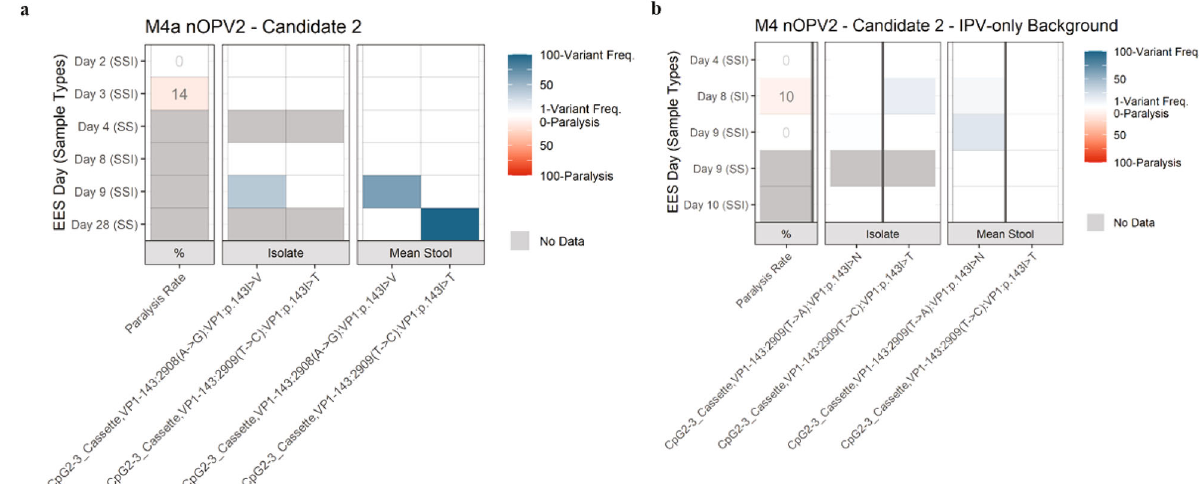
Fig. 6 nOPV2-c2. Frequency of variants in EES at known attenuation sites and mTgmNVT results. Participant vaccination history is IPV only. EES day shown with mTgmNVT result (red colour gradient) and variant frequency (blue colour gradient) averaged across two stool replicates (SS) and culture-ampli fi ed virus (I), if present. Amino acid associated with variant indicated, if applicable. S = Stool replicate; I = Culture- ampli fi ed virus isolate (SSI = Two stool replicates and culture-ampli fi ed virus isolate; SI = Single stool replicate and isolate). White cells = variant not detected. Grey cells = mTgmNVT result not available or no NGS data from stool (S)/culture-ampli fi ed virus (I). The NGS pipeline reports the variants as SNPs. Coding impact assumes changes are not in common genomes when multiple variants are observed in VP1-143. a M4a phase 1 trial nOPV2-c2 cohort. b M4 phase 2 trial nOPV2-c2 cohort. All variants reported have Q scores ≥